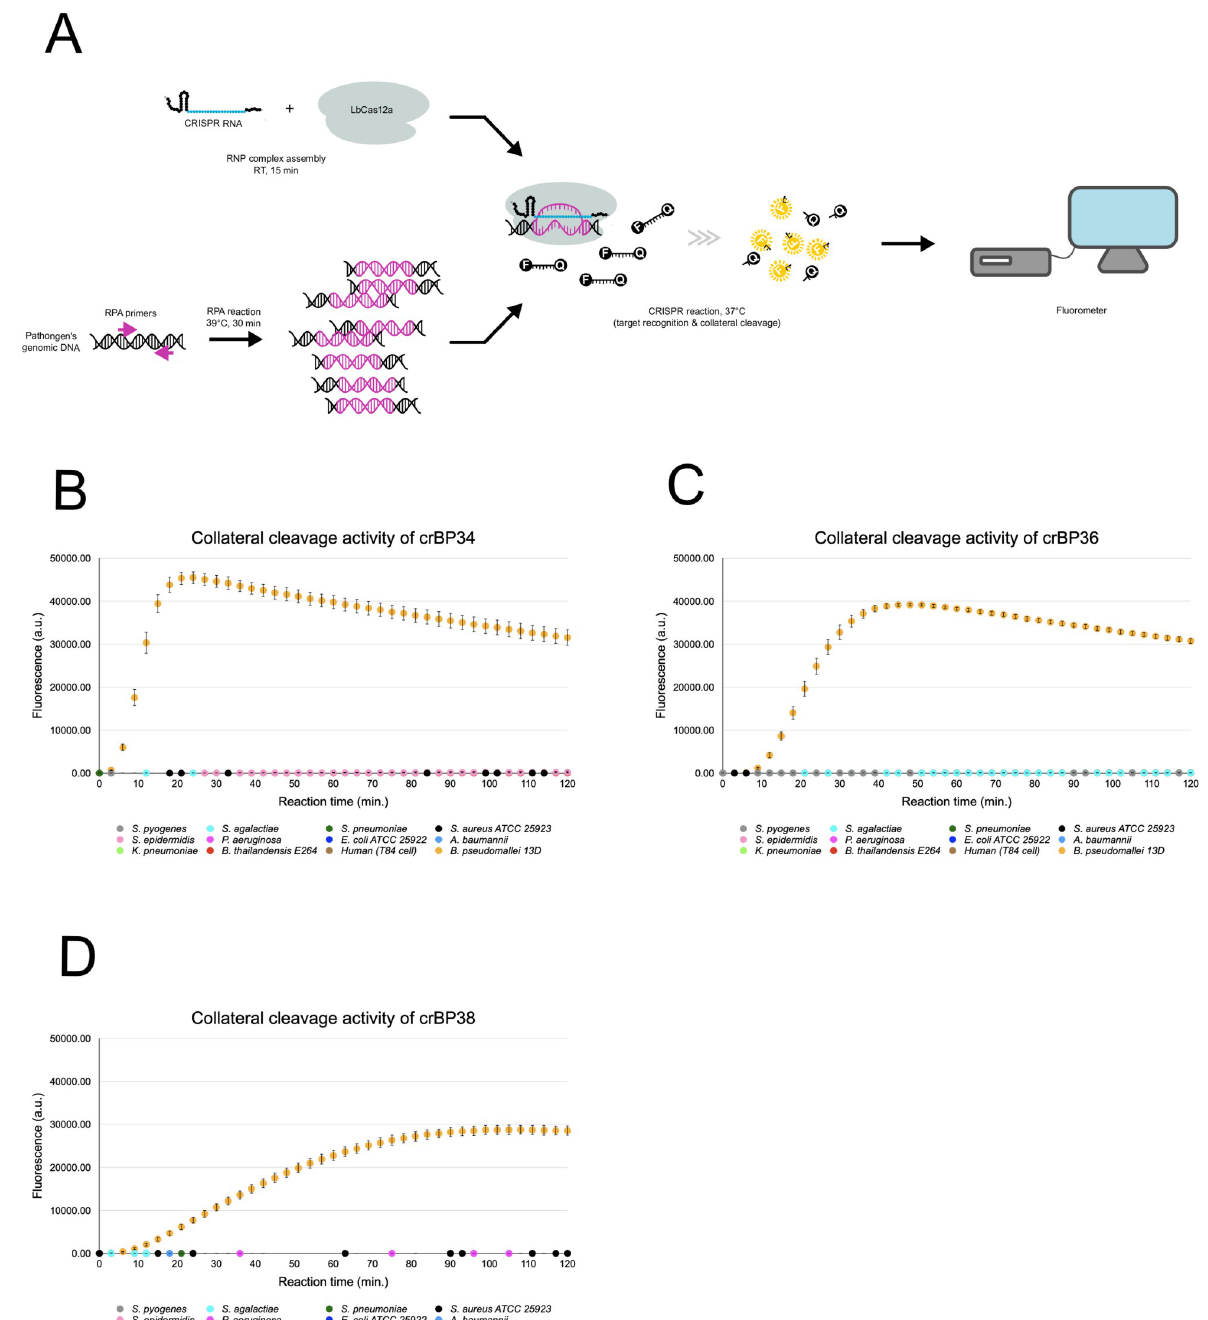
Fig 2. Specific detection of B . pseudomallei genomic DNA by the designed CRISPR-Cas12a. (A) A schematic representation of DETECTR assay. First, a region containing the CRISPR-Cas12a target site in the pathogen’s genomic DNA is pre-amplified by flanking primers (magenta arrows) in an isothermal amplification reaction called RPA. This amplified DNA is then combined with the pre-assembled CRISPR-Cas12a RNP complex in a CRISPR reaction that contains FAM-Quencher ssDNA probes (F-Q). Recognition of CRISPR RNP to its target self-activates its trans cleavage (collateral cleavage) activity. This results in cleavage of the FAM fluorophore from its quencher, hence the generation of a fluorescent signal, which can be detected by fluorometer. (B, C, D) Collateral cleavage activity of crBP34, crBP36 and crBP38, respectively. Each CRISPR-Cas12a RNP complex was tested against genomic DNA from a human cell line and 11 other pathogens, including B . thailandensis and B . psedomallei . ~10,000 copies of genomic DNA were used in 40- μ l RPA reactions, of which 3 μ l were used in 100- μ l CRISPR reactions. Fluorescent signals were collected every three minutes. Signals from CRISPR reactions that contained water-input RPA were used for background subtraction. Each data point represents an average from six CRISPR reactions derived from two independent sets of RPA reactions. Note that some data points sporadically